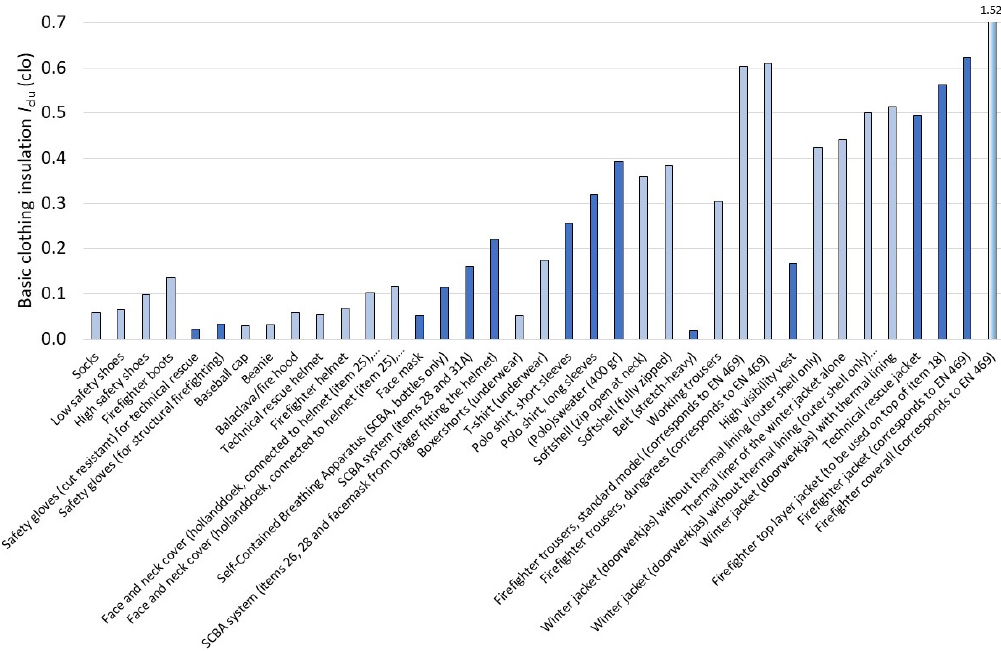
Figure A1. Basic clothing insulation of the tested items ( I clu , clo). As the firefighter coverall had over 2 times higher basic insulation, the y ‐ axis scale was not extended to that level, but the value (1.52 clo) is given above the top of this column. Alternating colour shade groups differentiate between product groups and/or body regions covered by these items, e.g., feet (socks, shoes), hands (gloves) head, SCBA element variations, etc.